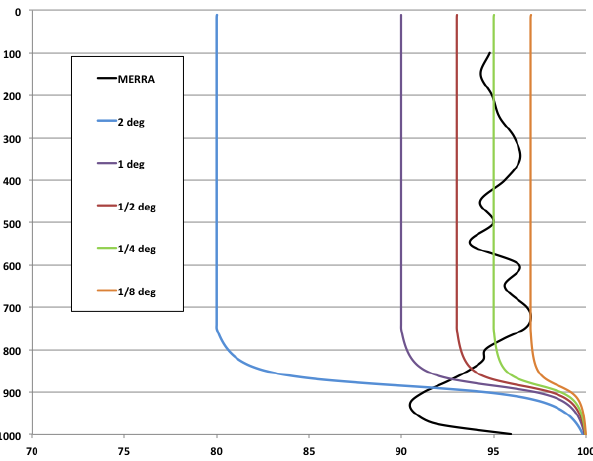
Figure 7. Critical relative humidity. Black from MERRA AGCM formulation, blue from MERRA2 AGCM formulation for 2-degree resolution, purple from MERRA2 AGCM formulation for 1-degree resolution, brown from MERRA2 AGCM formulation for 1 / 2- degree resolution, green from MERRA2 AGCM formulation for 1 / 4-degree resolution, orange from MERRA2 AGCM formulation for 1 / 8-degree